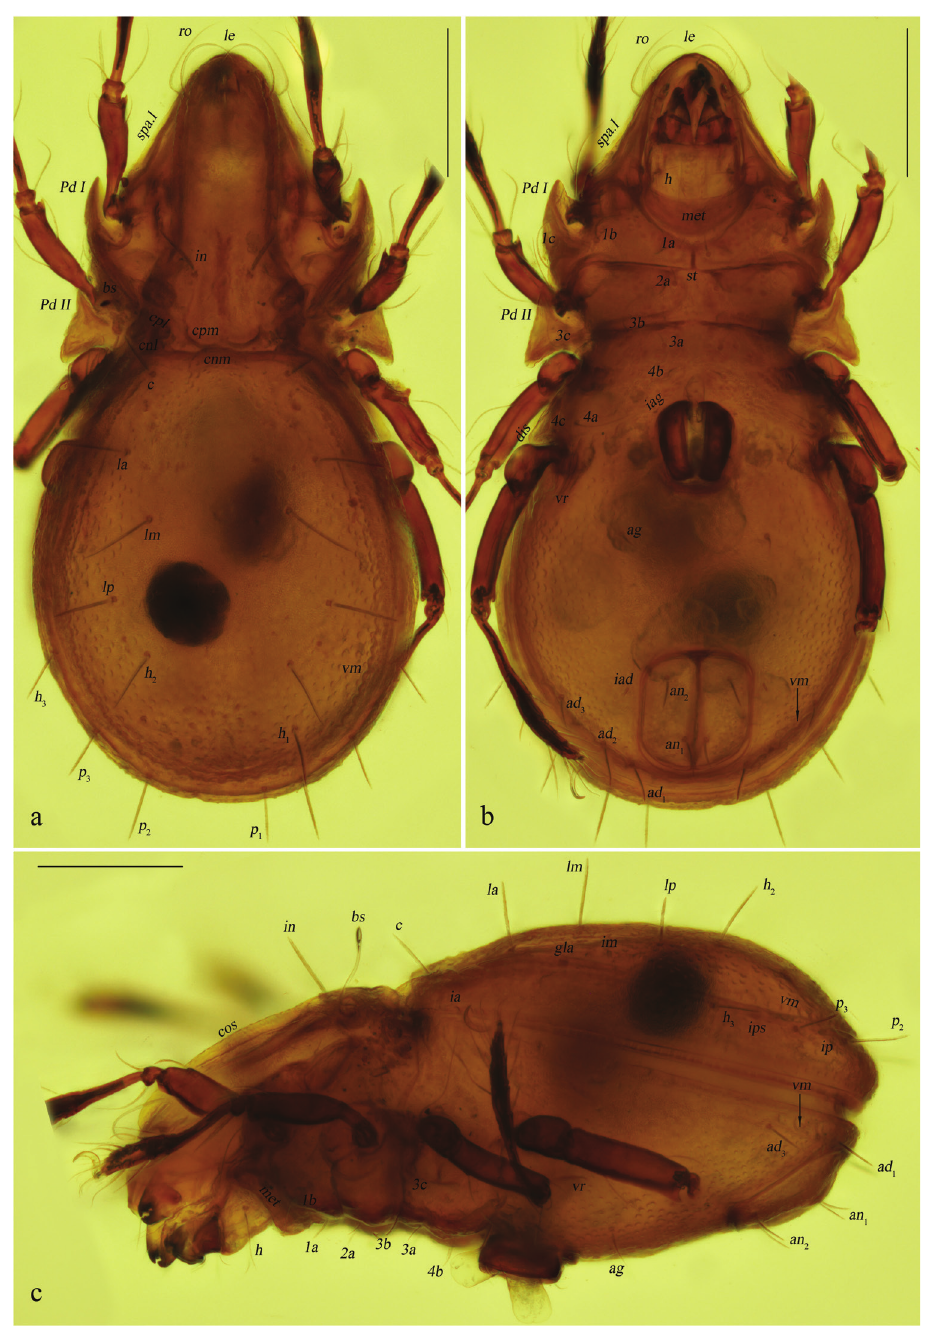
Figure 2. Basiceramerus ovatus sp. nov., adult, microscope images: a dorsal view b ventral view c lateral view. Abbreviations and notations explained in text. Scale bars: 200 μm ( a–c